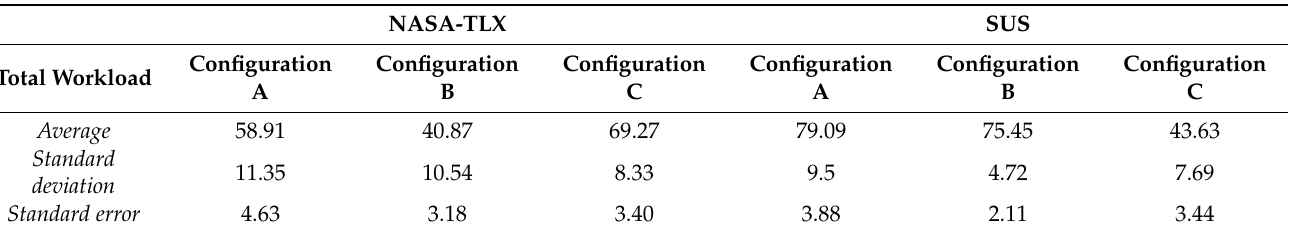
Table 1. Experimental results of the NASA Task Load Index (NASA –TLX) and System usability scale (SUS)